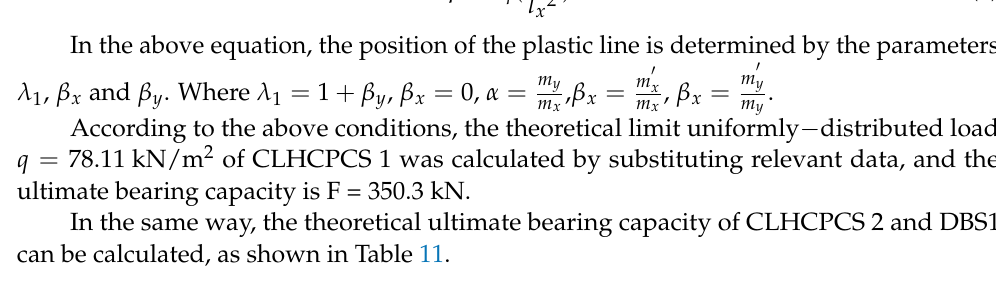
Table 11. Cracking load statistics of the superimposed surface of the specimen. Composite Plate Specimen